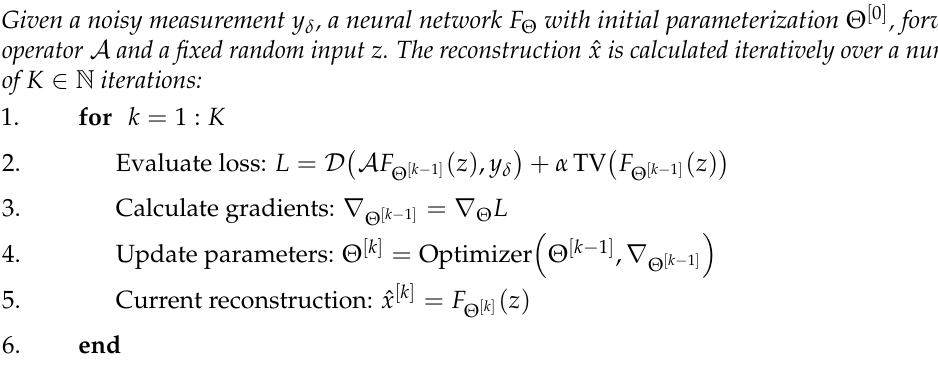
Algorithm A4 Deep Image Prior + Total Variation (DIP +